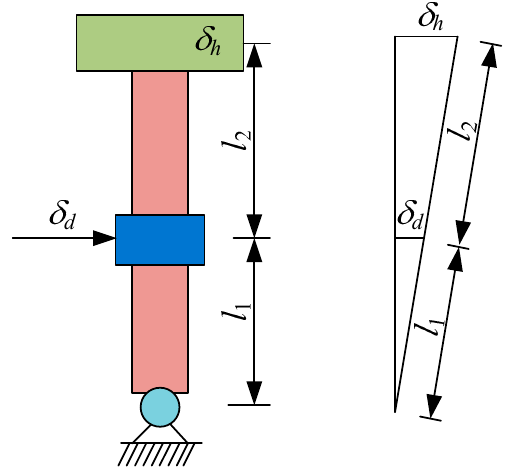
Figure 3. Displacement calculation diagram of harmonic rod.